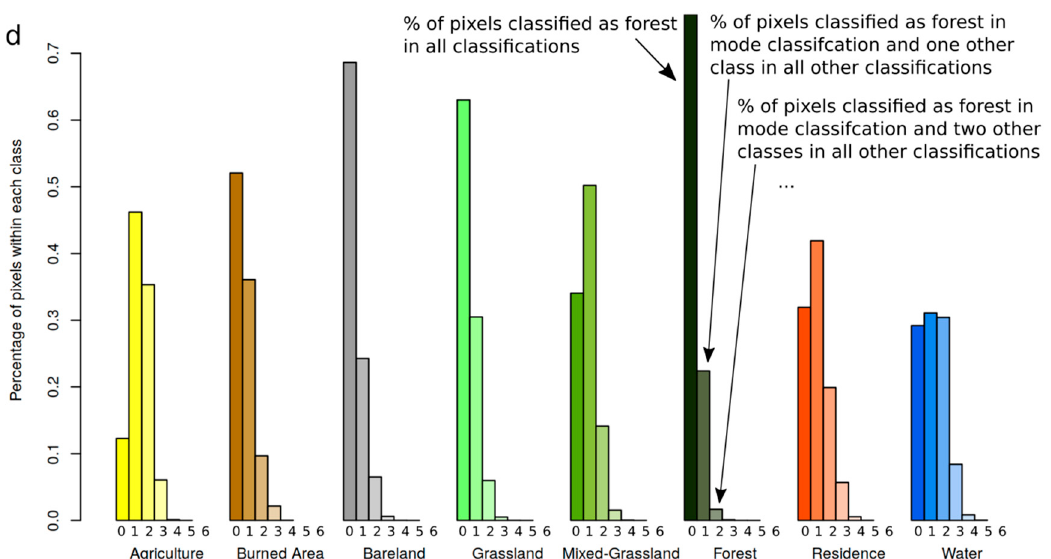
Figure 6. ( a ) Mode of classifications giving the class with the highest frequency per pixel among all 8 classifications. ( b ) Agreement between mode of classifications and the classification with the highest OA (classification based on Dataset 7) for the area around Ulaanbaatar indicated by the red box in ( a ). Pink areas mark disagreement. ( c ) Same as ( b ) but showing disagreement between all single classifications. In this respect, all pixels are colored in pink that are classified into at least two different classes considering all classifications. ( d ) Frequency of class numbers observed among all classifications given as class wise percentage of pixels in mode classification. The bars marked with zero show the percentage of pixels with agreement in all classifications. For instance, 76% of forest pixels (dark green bar) in mode classification are classified as forest in all other classifications; 22% of forest pixels in mode classification are put into another class than forest in at least one other classification; 2% of forested pixels in mode classification are put into 2 other classes. Please note that numbers in ( d ) are calculated for the entire area of the classifications.